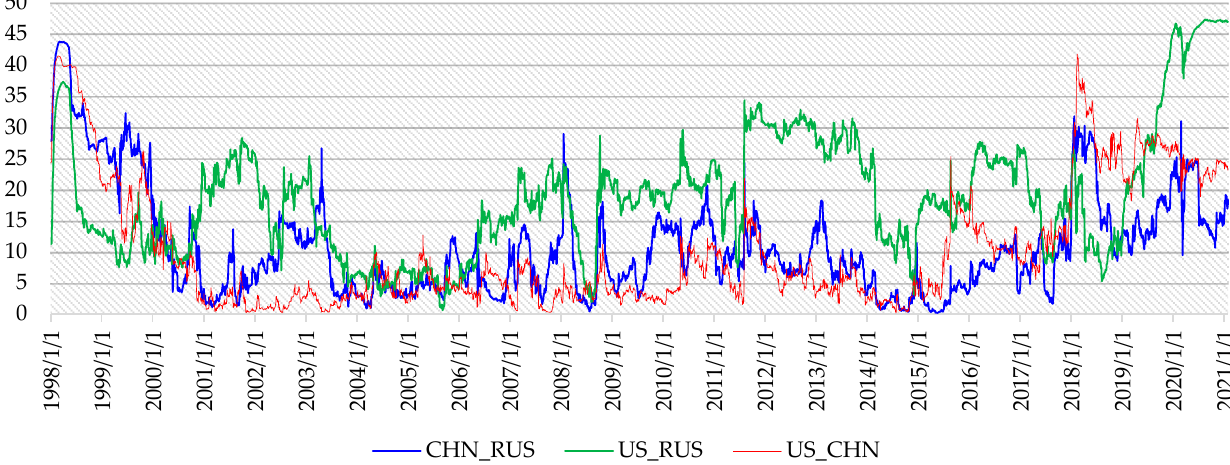
Figure 4. Pairwise dynamic connectedness. Source: Authors’ estimations.